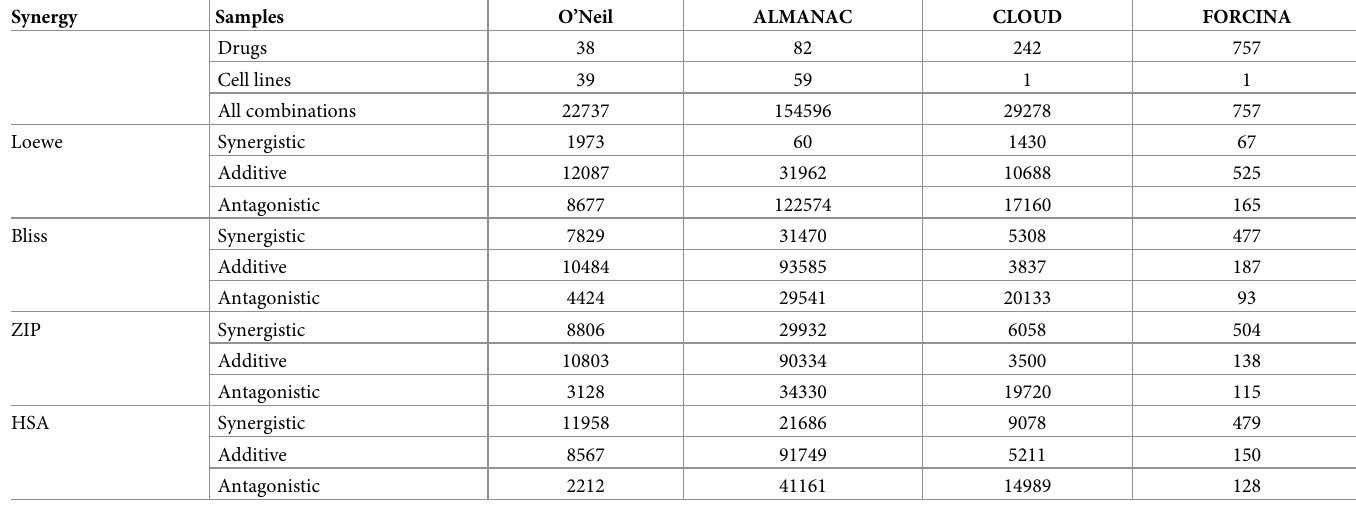
Table 5. Summary of the drug combinations’ synergy data for different datasets. Synergy